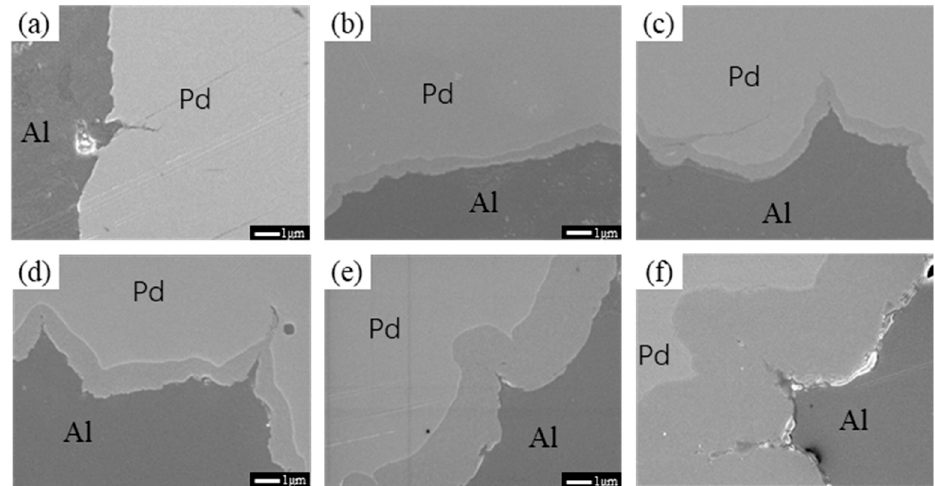
rates of Al and Pd lead to the generation of different phases at the interfaces annealed at different temperatures. After annealing at 200 °C, 250 °C and 300 °C for 10,800 s, the in- Figure 8. SEM images of Pd/Al composite wires annealed at 350 ◦ C for different times; ( a ) 5 s, ( b ) 60, termetallic compound at the interface is the Al 3 Pd 2 and Al 21 Pd 8 phases, and after annealing Figure 8. SEM images of Pd/Al composite wires annealed at 350 °C for different times; ( a ) 5 s, ( b ) ( c ) 120 s, ( d ) 300 s, ( e ) 3600 s, and ( f ) 10,800 s. at 350 °C for 10,800 s, the intermetallic compound at the interface is the Al 3 Pd 2 phase. 60, ( c ) 120 s, ( d ) 300 s, ( e ) 3600 s, and ( f ) 10,800 s